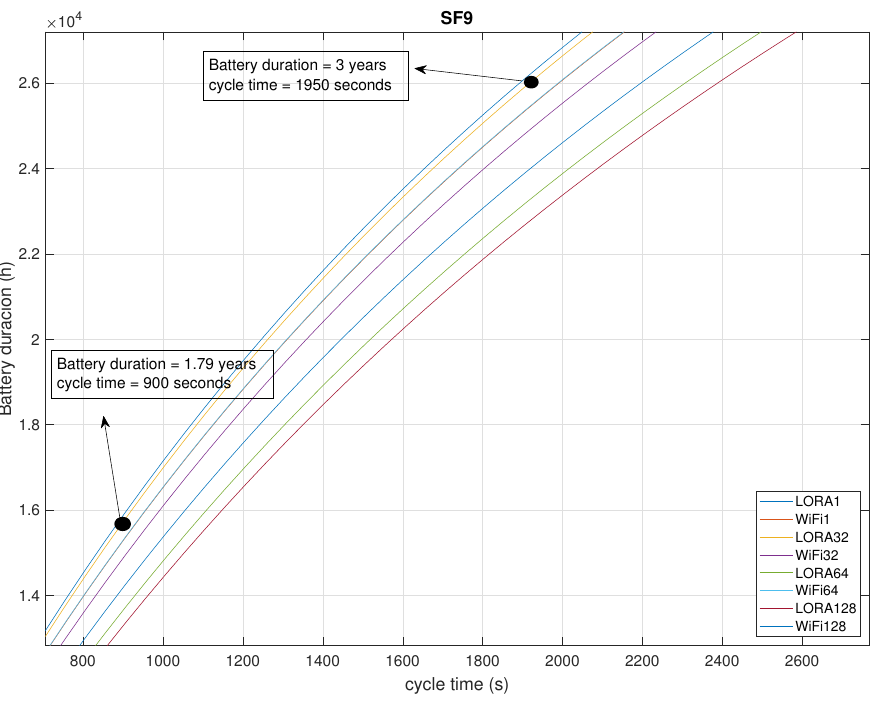
Figure 14. Battery duration with the parameters used in the STARPORTS